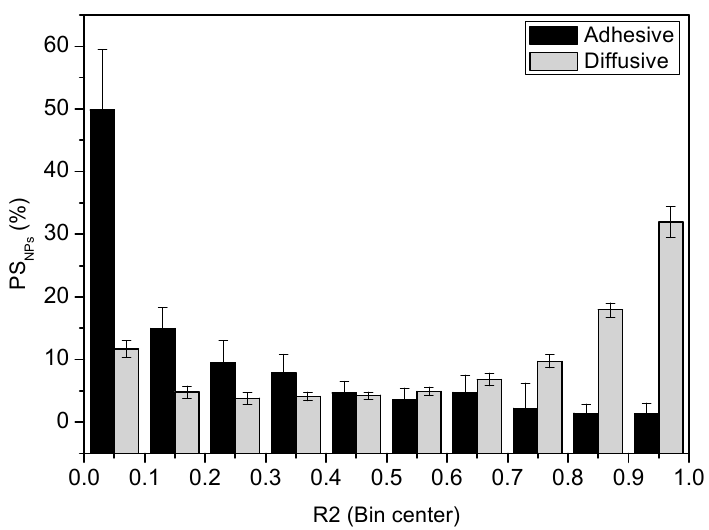
Figure 4. Distribution of trajectories (%) of mucoadhesive (black columns) and mucodiffusive (grey columns) PS NPs as a function of R 2 . Normally, high R 2 values are associated with diffusive trajectories.